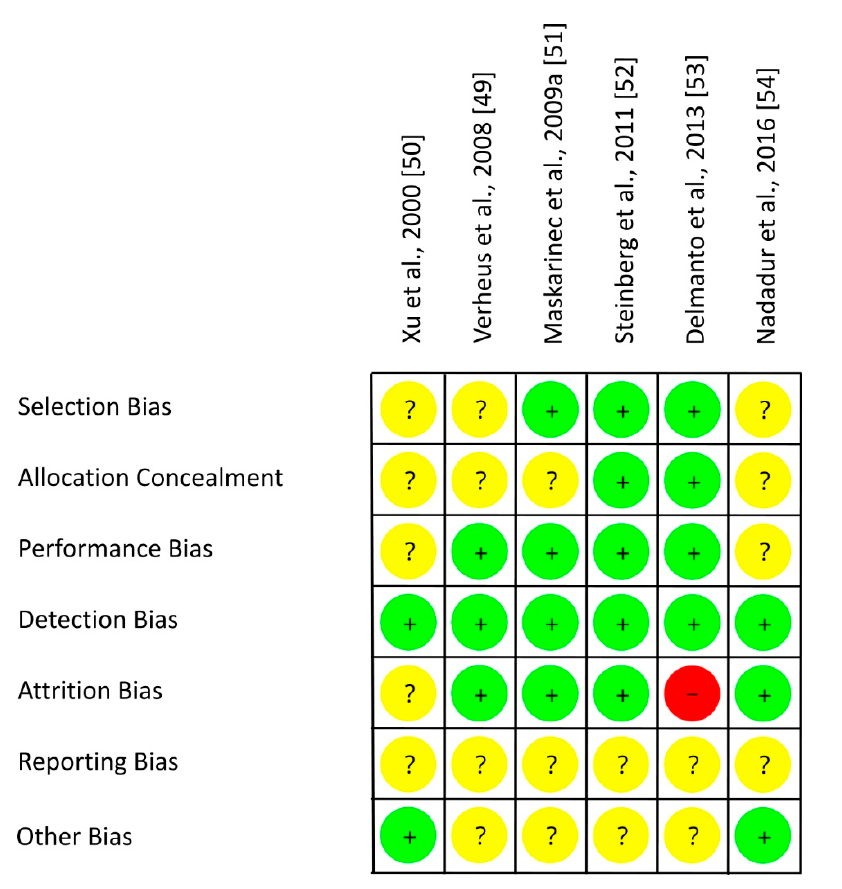
Figure 4. Risk of bias for studies with postmenopausal women. Green (+), low risk of bias; yellow (?), unclear risk of bias; red ( − ), high risk of bias.